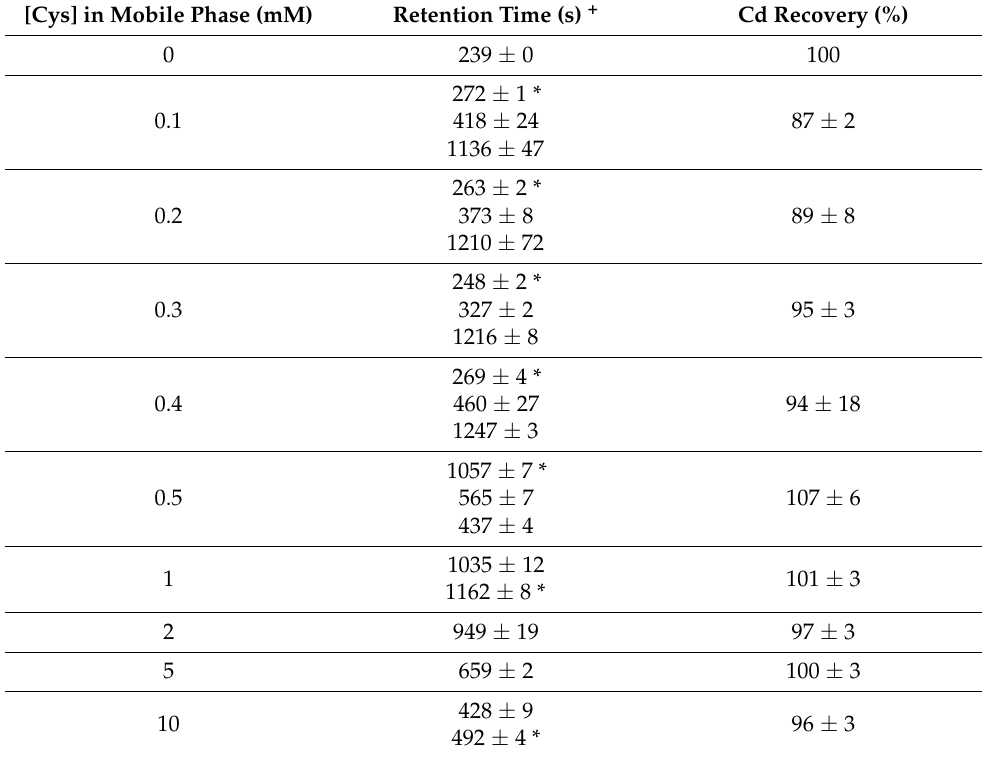
Table 1. Results obtained after the analysis of Cd 2+ (50 µ g) on an HPLC-FAAS system using mobile phases that contained 100 mM of NaCl, 5.0 mM Tris-buffer (pH 7.4), and increasing concentra- tions of cysteine (Cys) (0 to 10 mM) using a Hamilton PRP-X100 (AEX) HPLC column at flow rate 1.0 mL/min and a Buck Scientific FAAS as the Cd-specific detector at 228.8 nm. [Cys] in Mobile Phase (mM) Retention Time (s) + Cd Recovery (%) 0 239 ± 0 100 272 ± 1 0.1